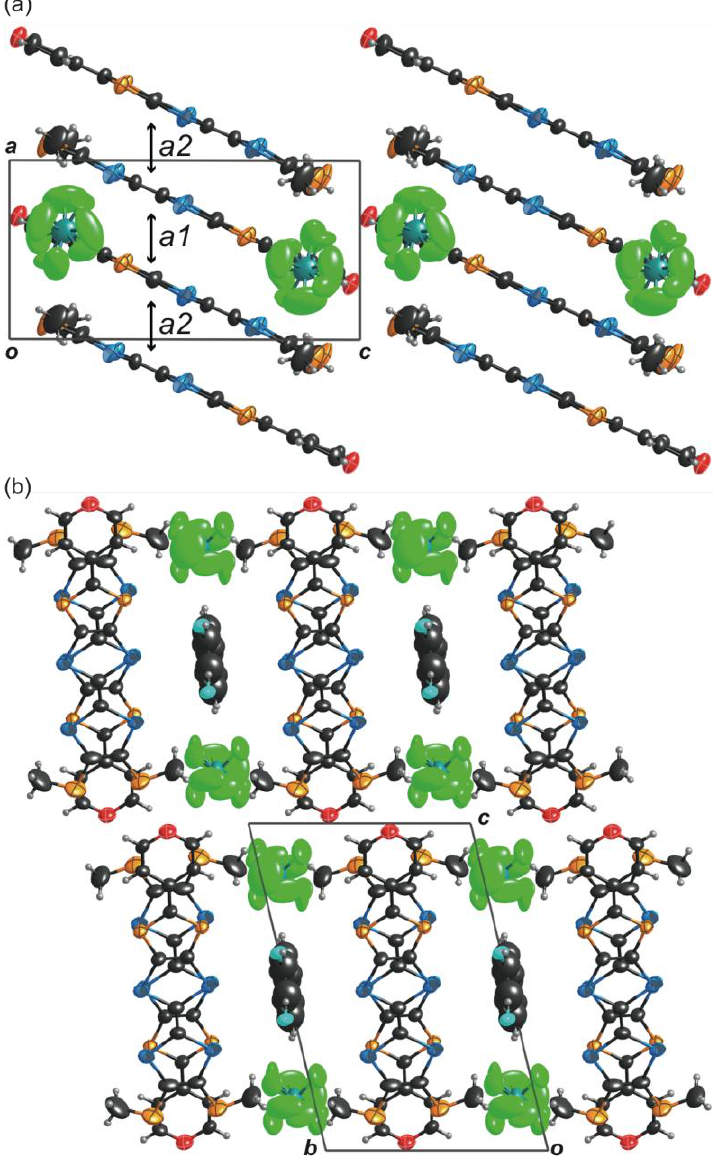
Figure 6. (a) Crystal structure of (TM-PDS-STP)PF The solvent molecules are omitted for clarity. (b) Crystal structure of